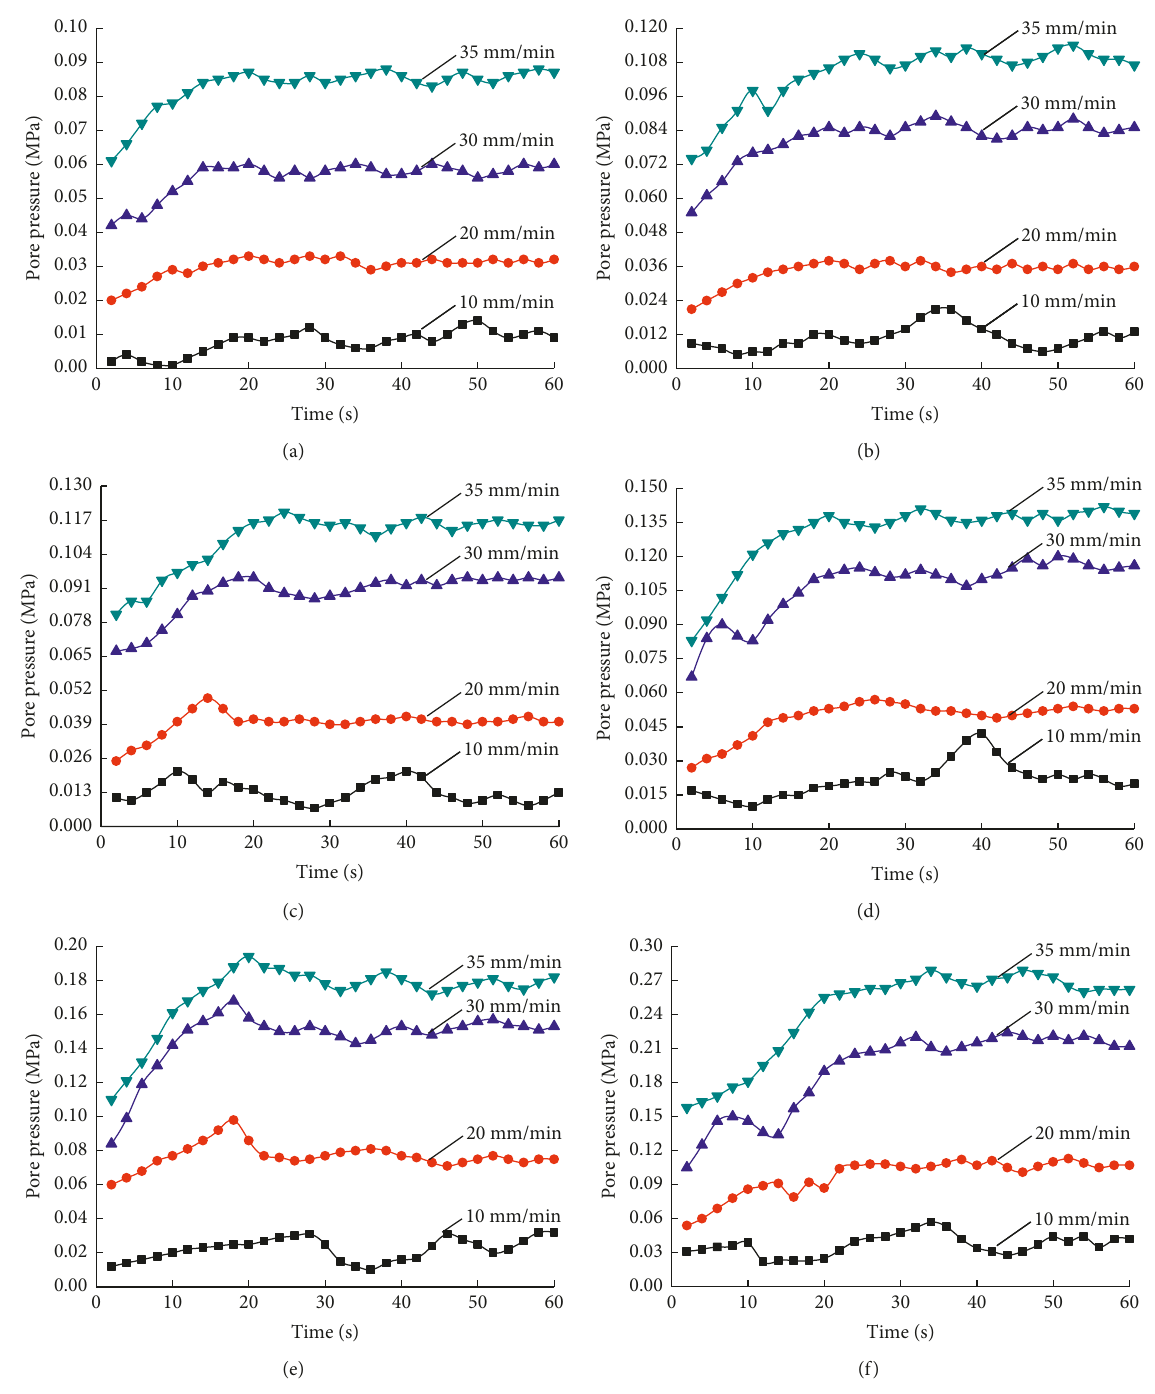
Figure 4: Graphs of pore water pressure vs. time at various axial displacement levels of specimen A (1 :0): (a) axial displacement 10mm (compression rate 9.5%); (b) axial displacement 15 mm (compression rate 14.3%); (c) axial displacement 20mm (compression rate 19.0%); (d) axial displacement 25 mm (compression rate 23.8%); (e) axial displacement 30mm (compression rate 28.6%); (f) axial displacement 35mm (compression rate